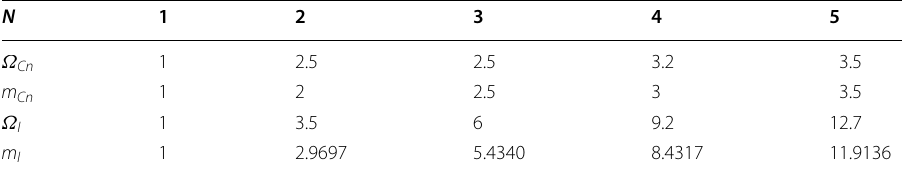
Table 5 Interference link parameters